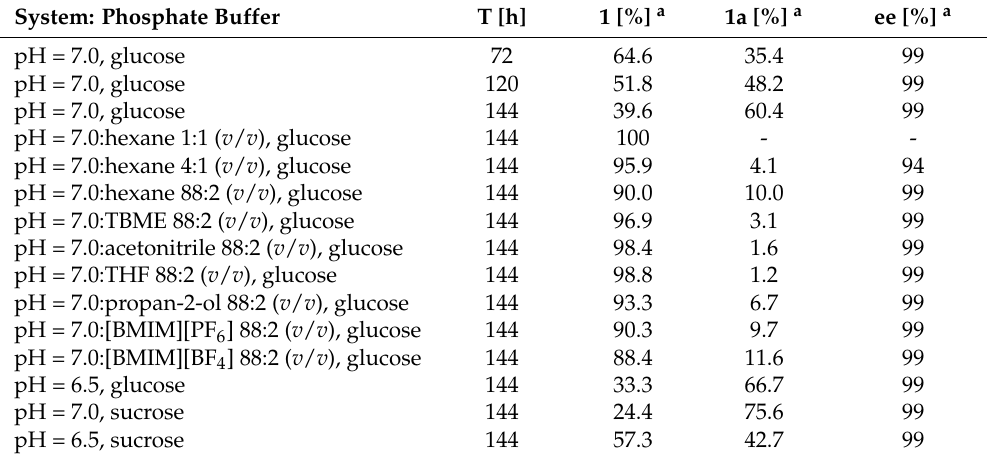
Table 1. Reduction of 1 by Aureobasidium pullulans